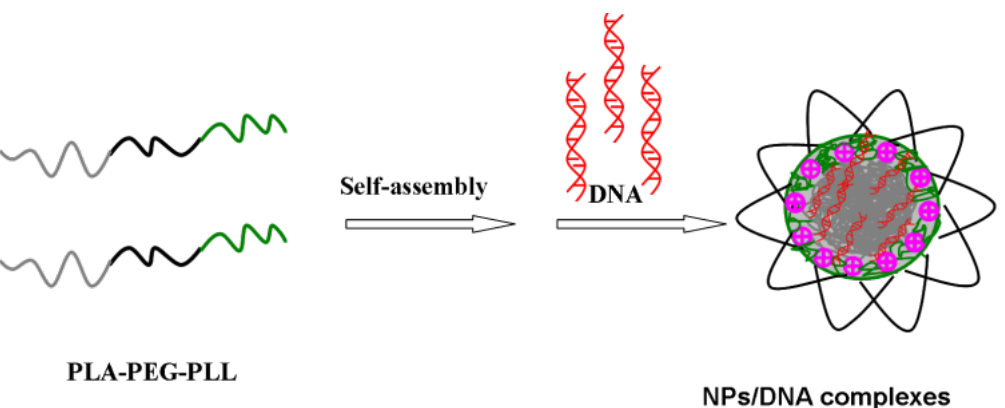
Figure 2. Schematic illustration of PLA-PEG-PLL NPs/DNA